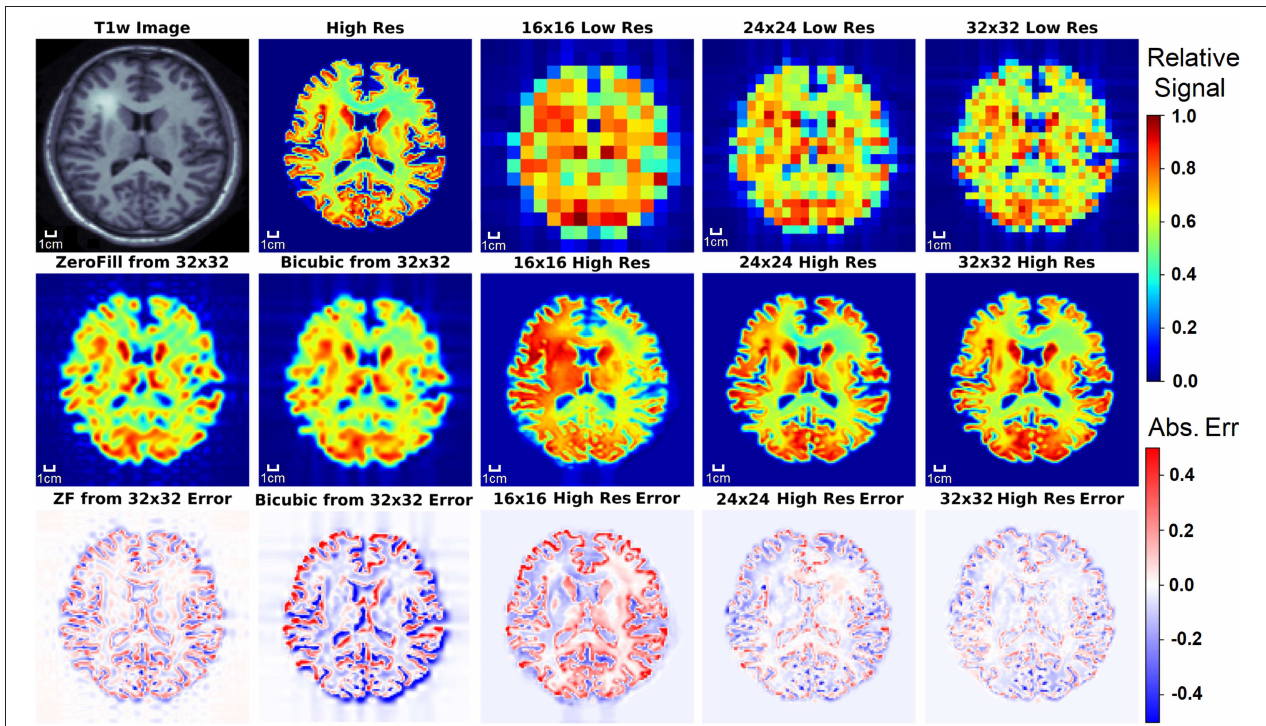
FIGURE 5 | The results of the three D-UNets are shown for an example test subject. The augmented T1w image is used in conjunction with the three low resolution images as inputs for the three D-UNets. The reconstructed HRSI (16x16 High Res, 24x24 High Res, and 32x32 High Res) are shown below their respective low resolution images. In addition, zero-filling and bicubic interpolation were applied to the 32x32 LRSI to produce 128x128 interpolated images. Error maps are produced by subtracting the reconstructed images and the ground truth high resolution image (High Res). The 16x16 High Res displays much more error than the 24x24 and 32x32 High Res images. This is mostly due to better local signal refinement at the location of the lesion for the 24x24 and 32x32